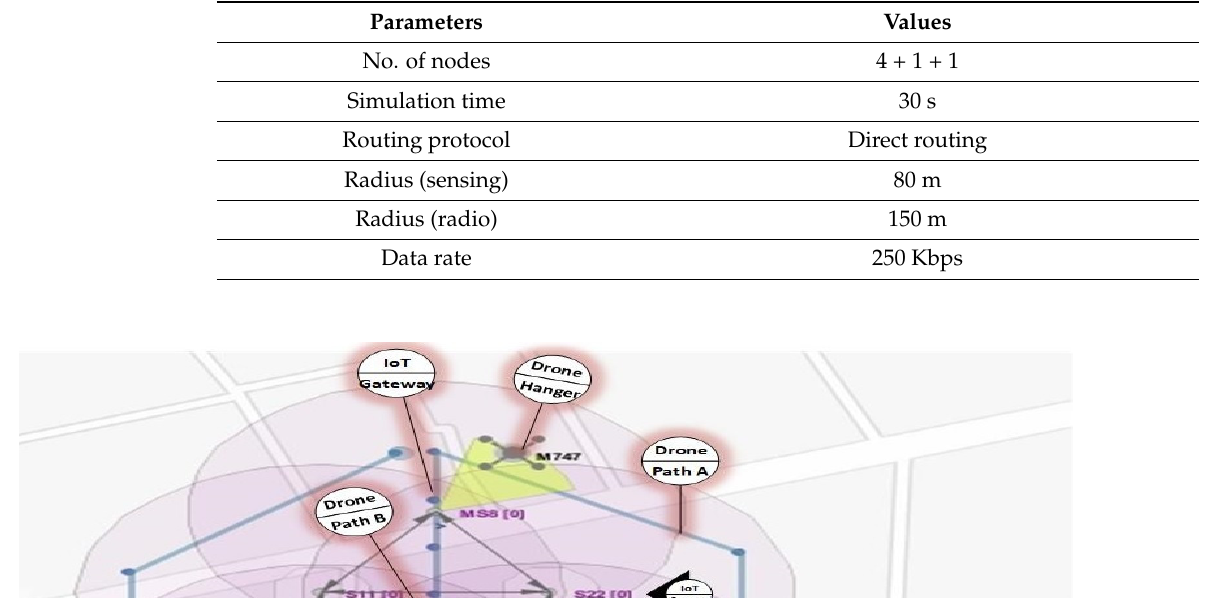
Table 3. General simulation parameters.